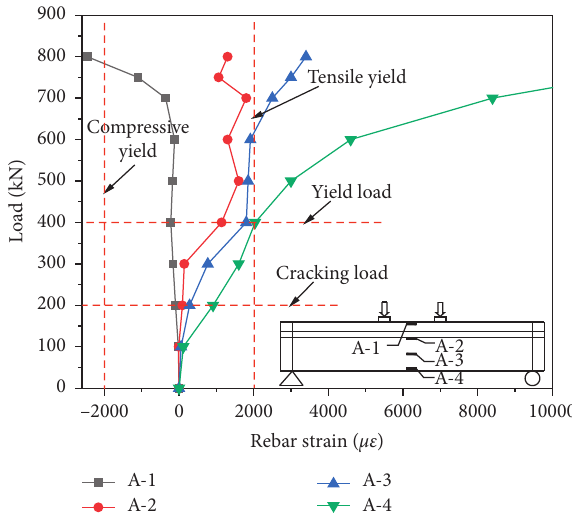
Figure 7: Load-strain curves in longitudinal rebars.